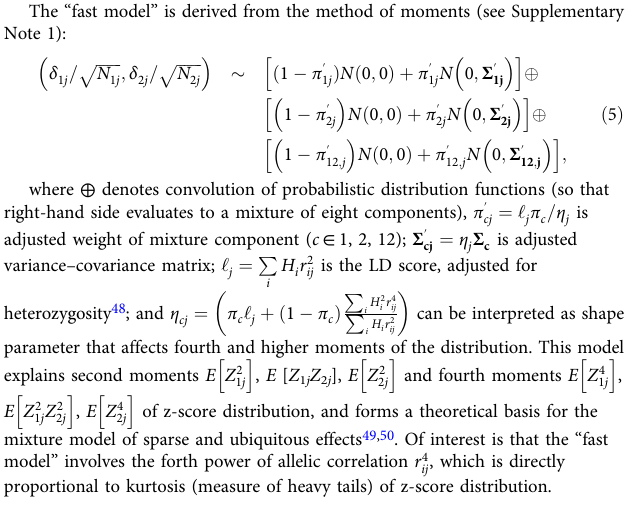
ffiffiffiffi p K , where